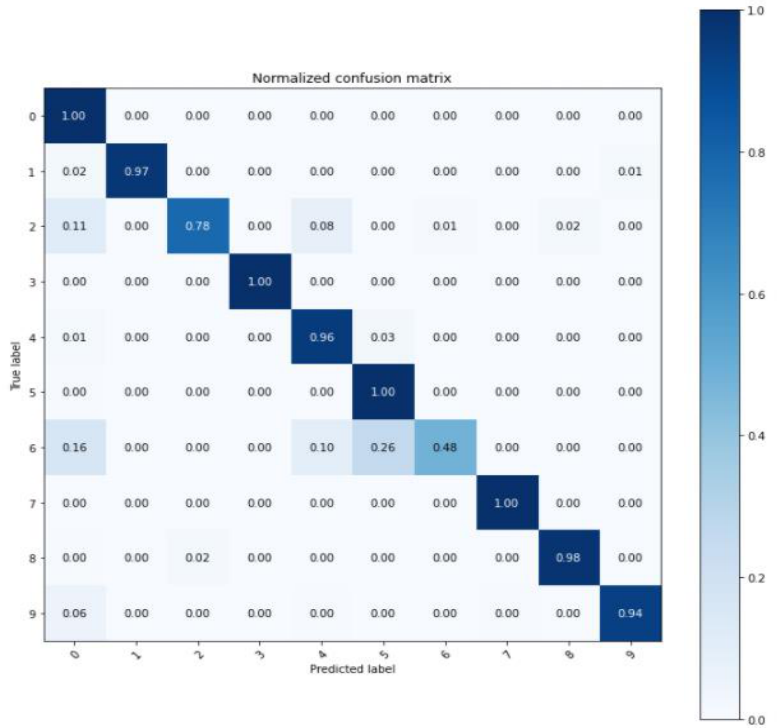
Figure 11. Confusion matrix of the proposed DAE + MS-CRNN model.